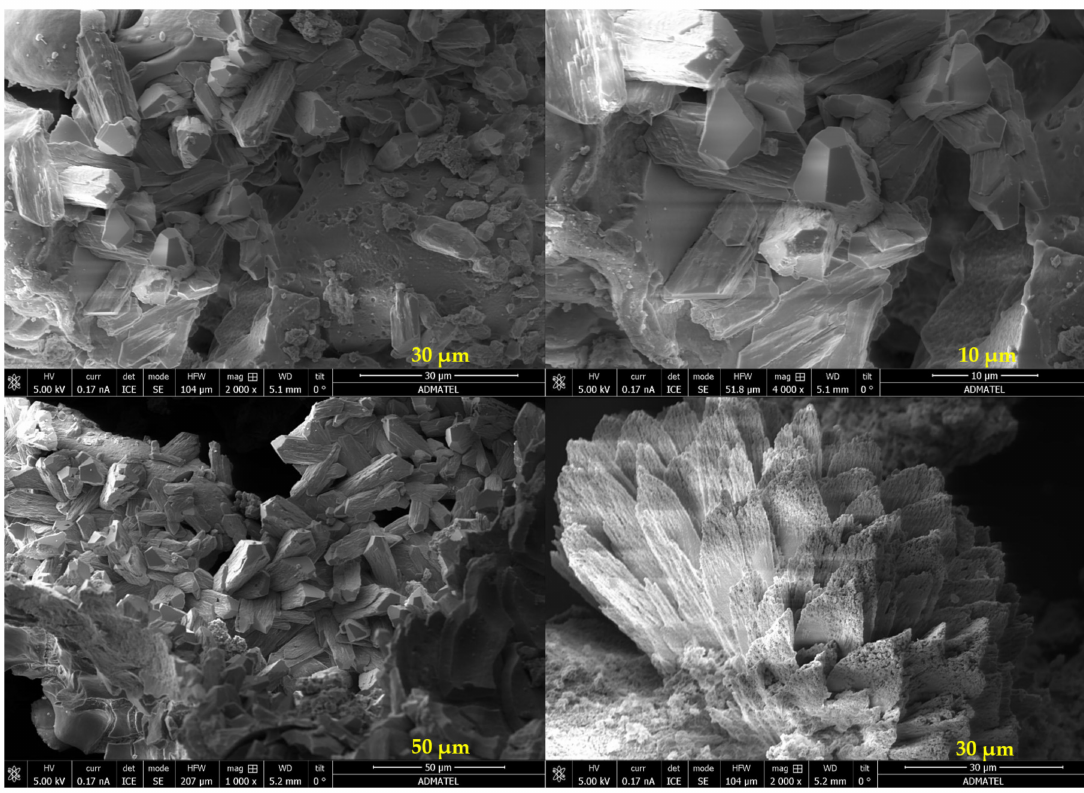
Figure 8. SEM images of the mineral precipitate in the geopolymer cracks.